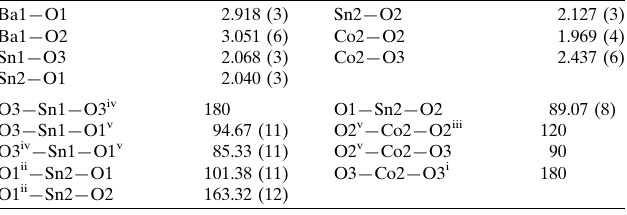
Selected geometric parameters (A˚ , (cid:3)